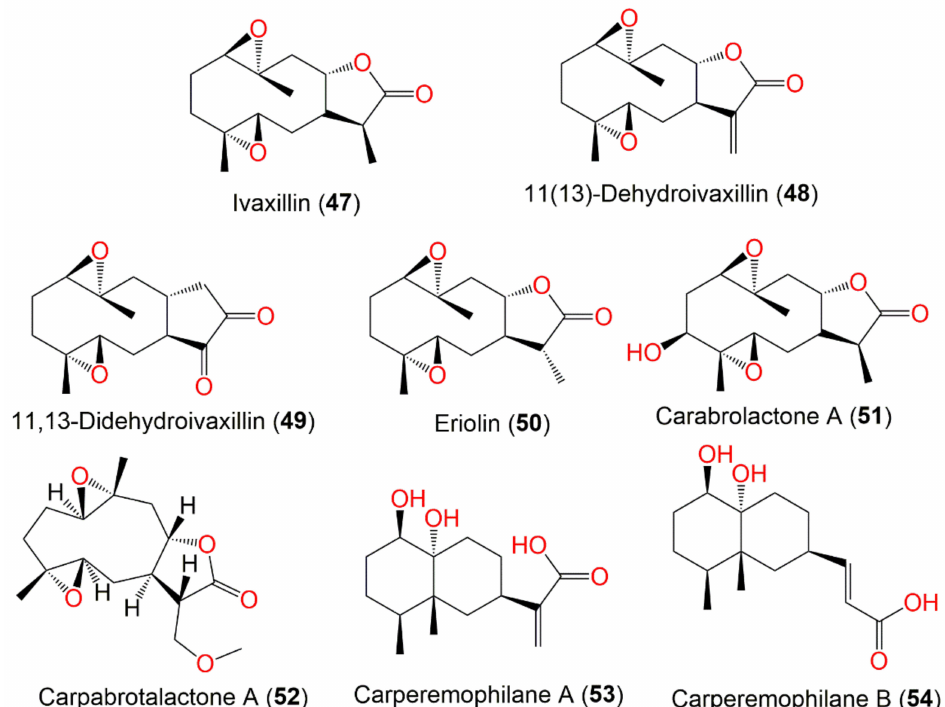
Figure 8. Germacranolide ( 47 – 52 ) and eremophilanoide ( 53 and 54 ) sesquiterpenes reported from C. abrotanoides